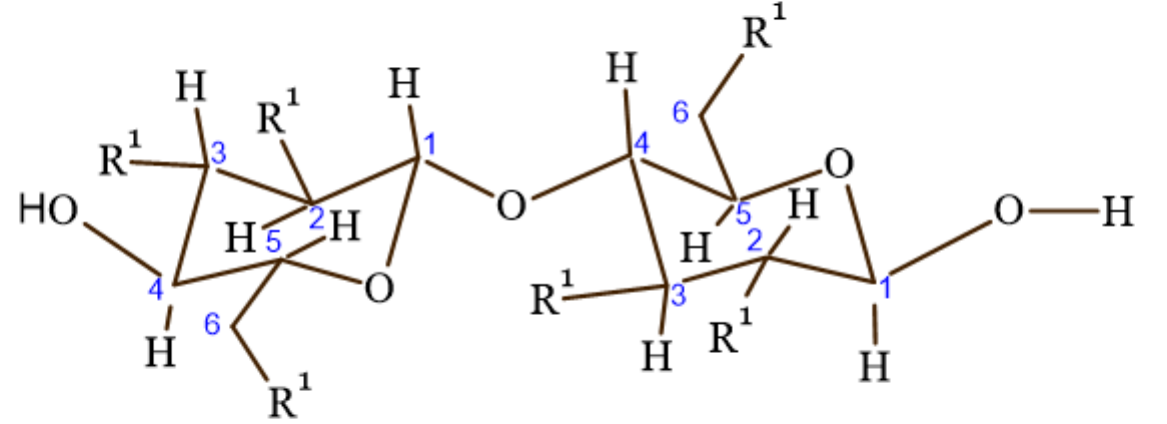
Figure 6. Chemical structure of ether derivatives, where R 1 is OCH 3, OCH 2 CH 3, OCH 3 , [CH 2 CH 2 O] n H, and O[CH 2 CH(CH 3 )O]H OCH 2 COONa for MC, EC, HEMC, HPC, and CMC, respec- tively.